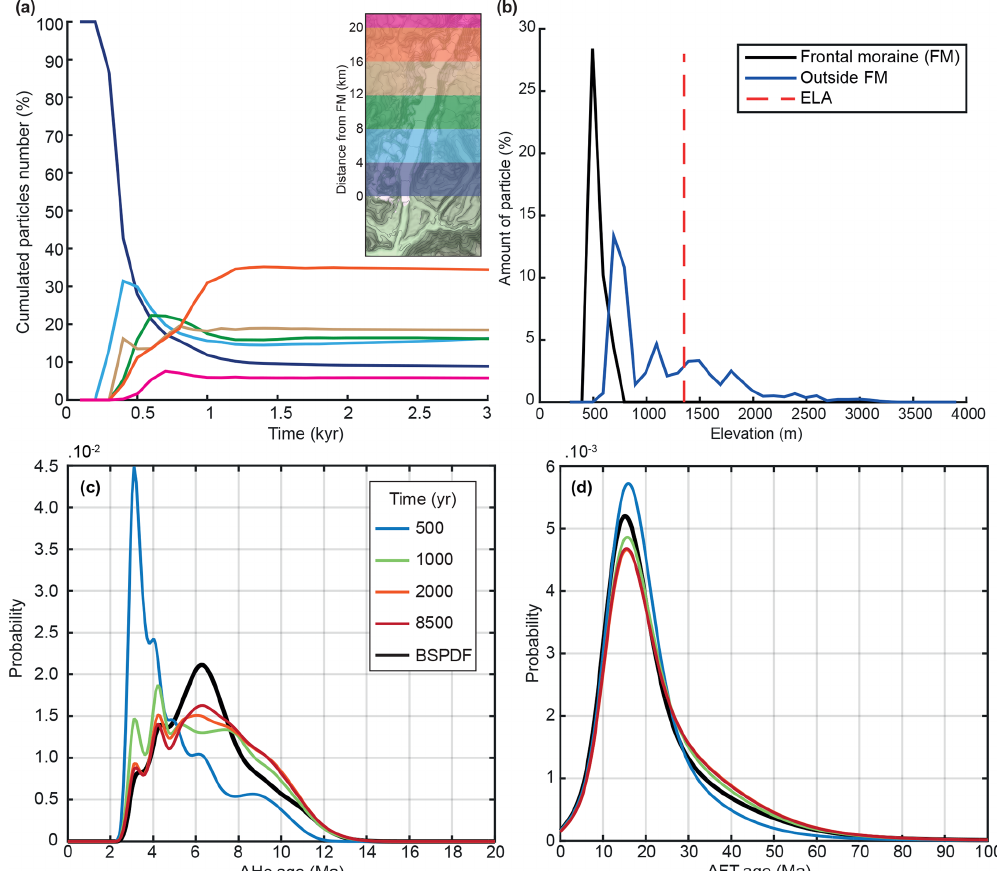
Figure 6. Transient evolution of particle sources and detrital thermochronological age distributions in the frontal moraine. (a) Cumulative contribution of source locations for particles and (b) their distribution with elevation after 8500 years of transport. Panels (c) and (d) show the transient evolution of the detrital thermochronological age distribution in the frontal moraine for AHe and AFT systems, respectively. BSPDF: bedrock